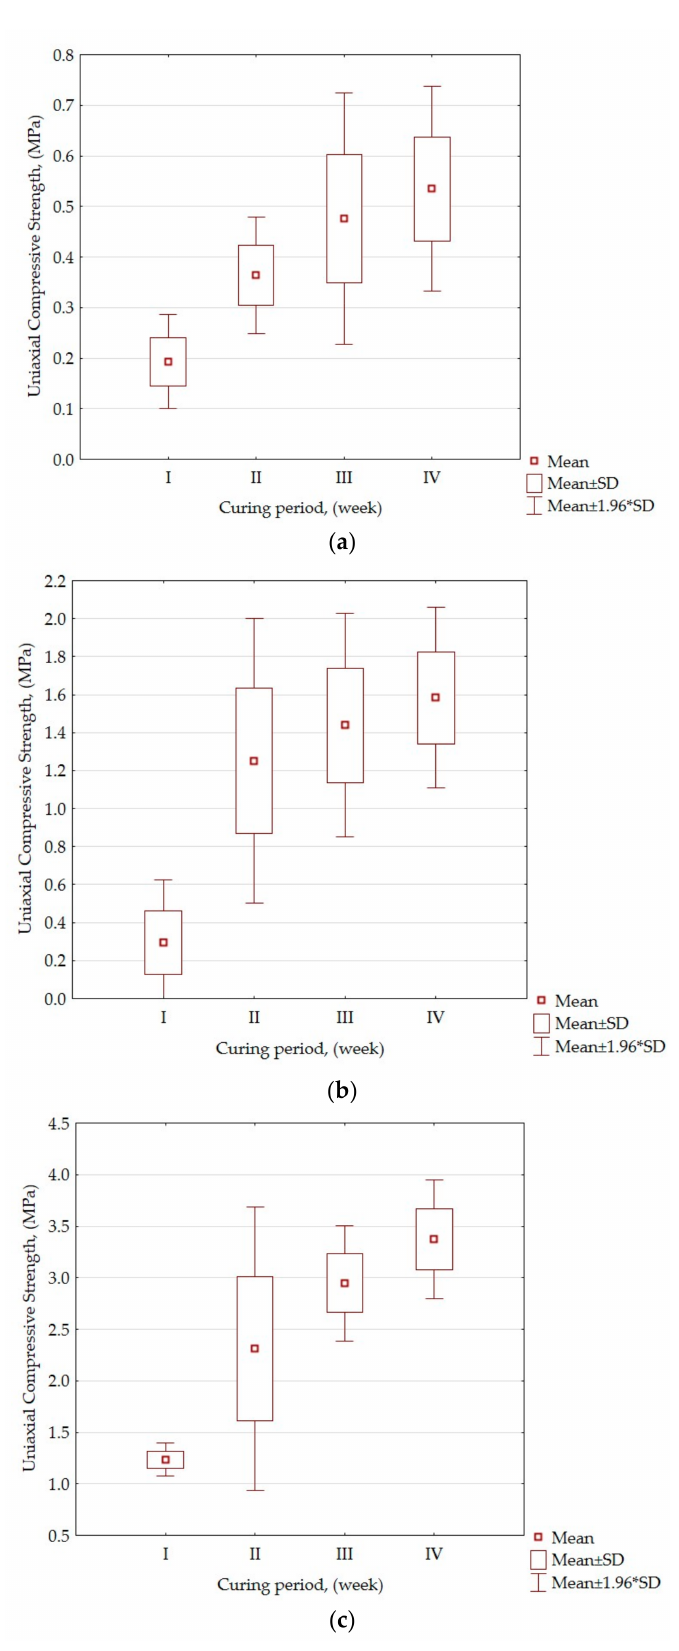
Figure 7. Uniaxial compressive strength of the paste backfill in the period up to the fourth week with addition of: ( a ) 5% cement; ( b ) 10% cement; ( c ) 15% cement. SD—standard